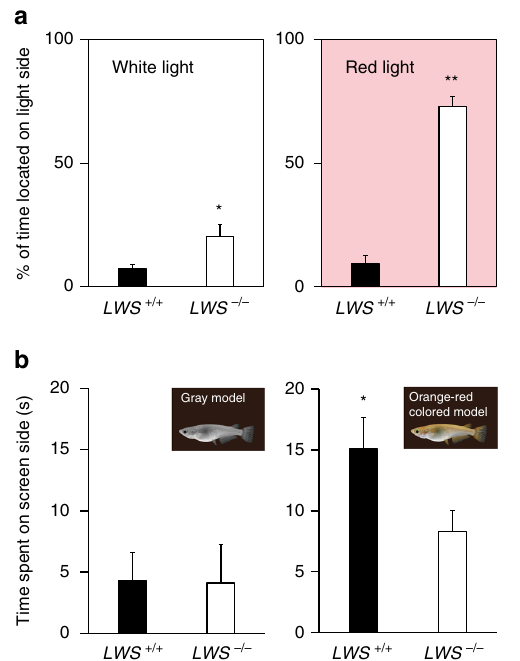
Fig. 3 LWS opsin-null fi sh exhibit defects in phototaxis and mate preference. a LWS − / − fi sh exhibited impaired negative phototaxis to white light compared to LWS +/+ fi sh under long day/warm temperature (LW) conditions (* P < 0.05, t -test; mean + SEM, n = 6 – 12). When white light was switched to red light, LWS − / − fi sh exhibited light-seeking behavior, whereas LWS +/+ fi sh continued to exhibit negative phototaxis (** P < 0.01, t -test; mean + SEM, n = 6 – 12). b Neither LWS +/+ nor LWS − / − fi sh kept under LW conditions showed a preference for gray model fi sh (* P > 0.05, t -test; mean + SEM, n = 10 – 11). LWS +/+ fi sh preferred orange-red-colored model fi